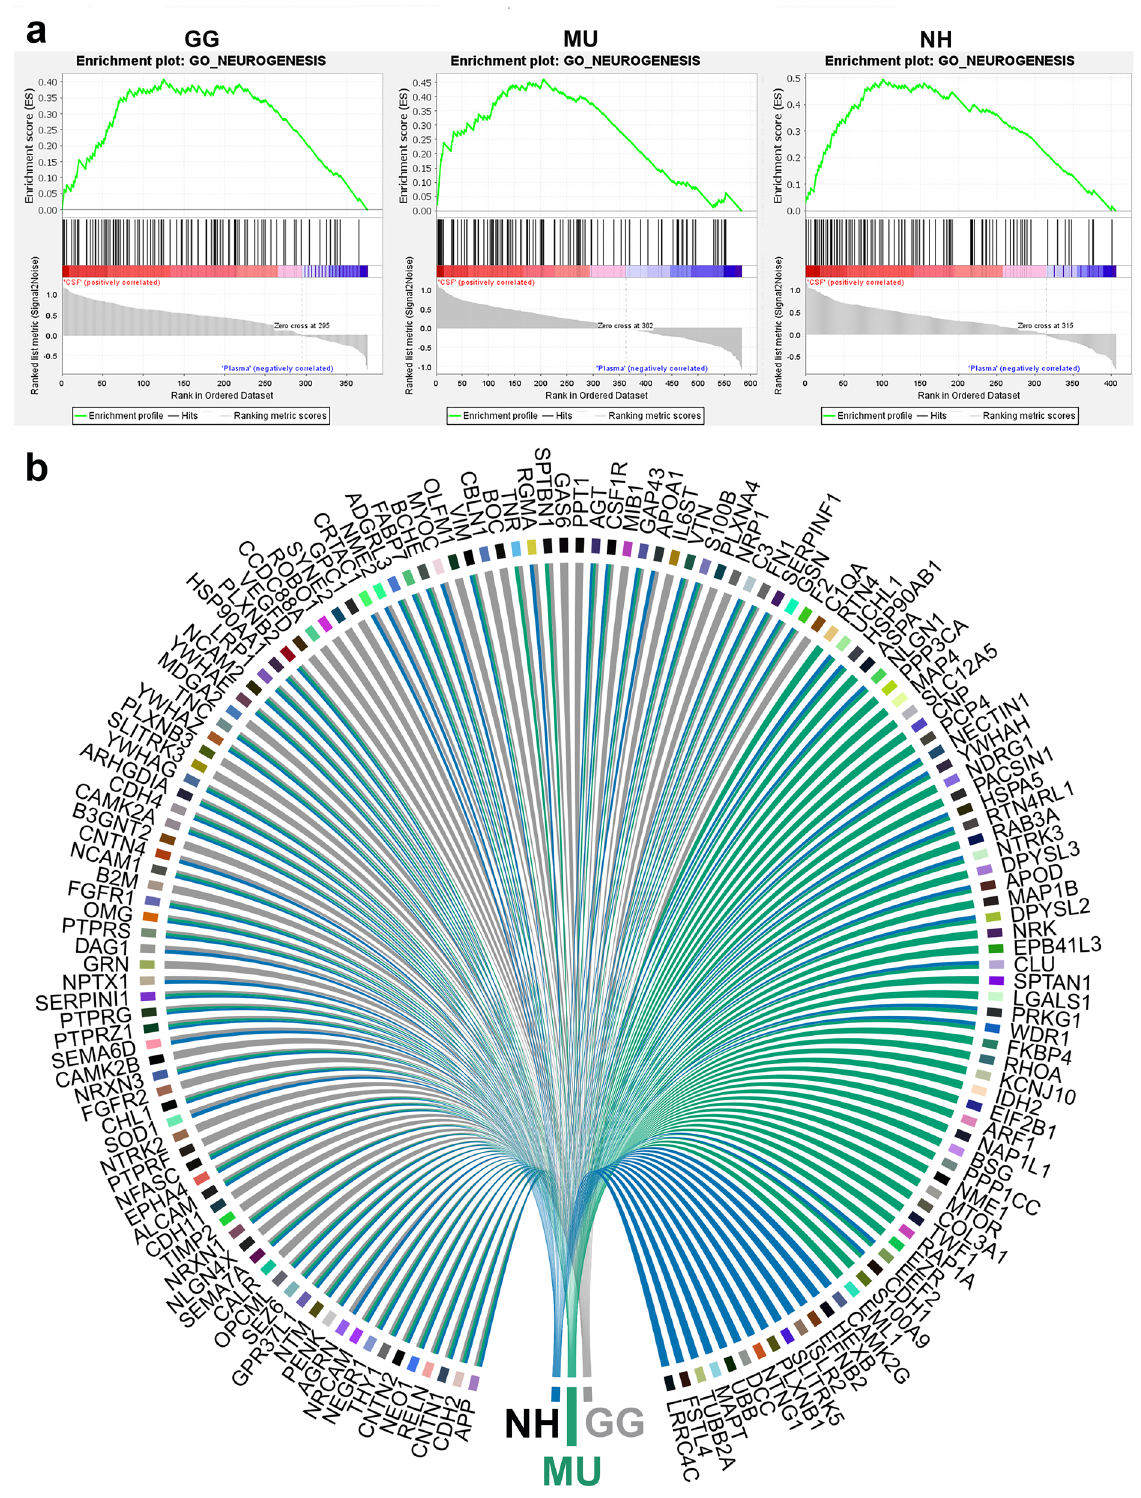
Figure 8. Gene set enrichment analysis (GSEA) and comparison of cerebrospinal fluid and plasma proteomes reveals neurogenesis in all studied avian species. ( a ) GSEA plots of the GO term Neurogenesis for chicken (GG), budgerigar (MU) and cockatiel (NH) in cerebrospinal fluid compared to plasma (GSEA version 4.1.0, http://www.gsea-msigd b.org) ( b ) Circular plot representation of proteins identified by GSEA with the GO term Neurogenesis for GG, MU and NH. The proteins are labelled by their gene codes (R version 4.0.0, www.r-proje